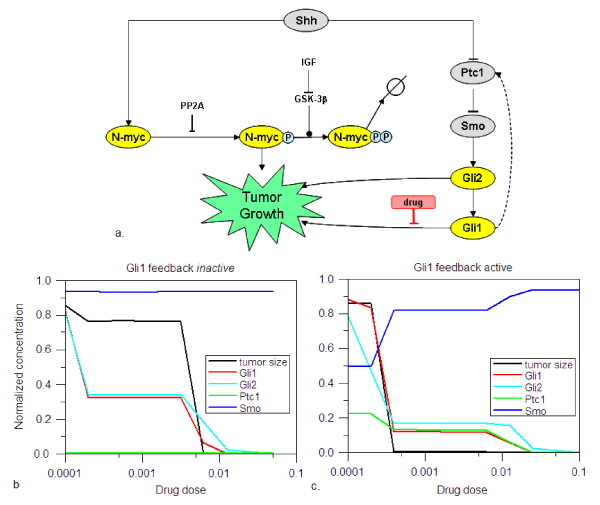
a. This model is similar to the one in figure 1, but a few more details concerning N-myc activation are added. The transforming event of figure 1 is constitutively on when Shh is high, so it is not shown here. Tumor growth requires Nmyc-P and either Gli1 or Gli2 to be active. b. the feedback loop shown as a dotted line from Gli1 to Ptc1 is inactive. The drug suppresses Gli1 and Gli2 activity downstream of Smo, inhibiting tumor growth, but high Smo levels allow continued expression of Gli2, which is able to activate the cell cycle. Only when high drug doses are present are Gli1 and Gli2 sufficiently suppressed to stop tumor growth. c. The feedback loop is now active; Gli1 and Gli2 are suppressed by the drug, but small levels of Gli1 are sufficient to activate Ptc1 production, supressing Smo expression, hence Gli2 is lower. As drug dose increases, Gli1 is suppressed and eventually Ptc1 production stops, allowing Smo to be expressed.